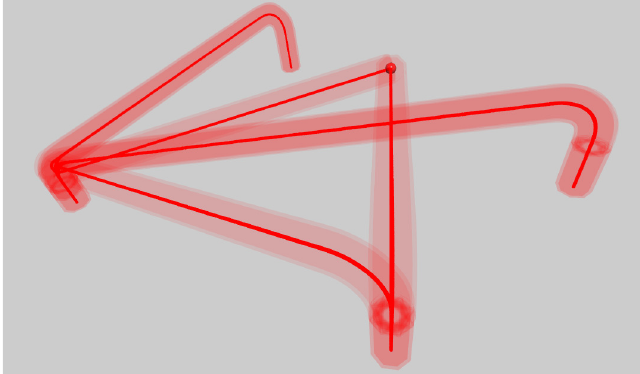
Figure 11. Trace of the tool visualized in TIA Portal.